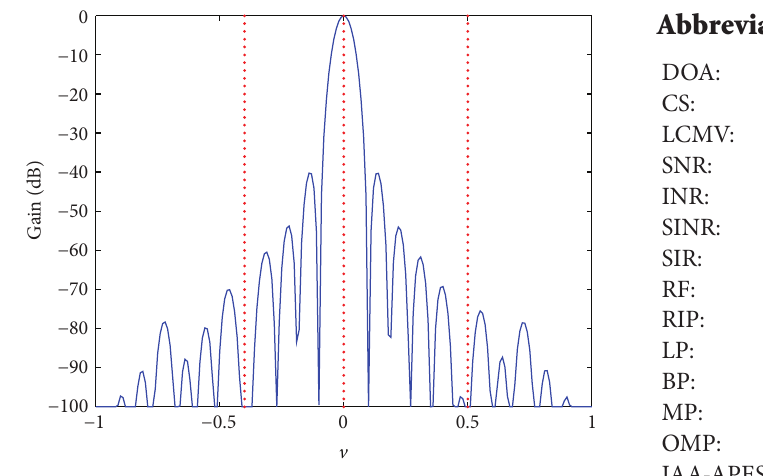
Figure 11: The beam pattern of planar circle array in U-cut plot with 𝑢 = 0.1